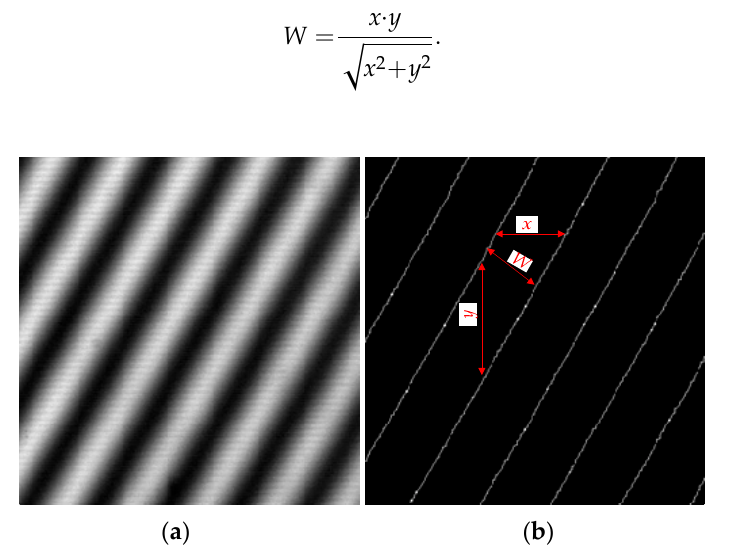
Figure 7. Moiré fringe image. ( a ) The original image; ( b ) extracted center lines. Figure 7. Moir é fringe image. ( a ) The original image; ( b ) extracted center